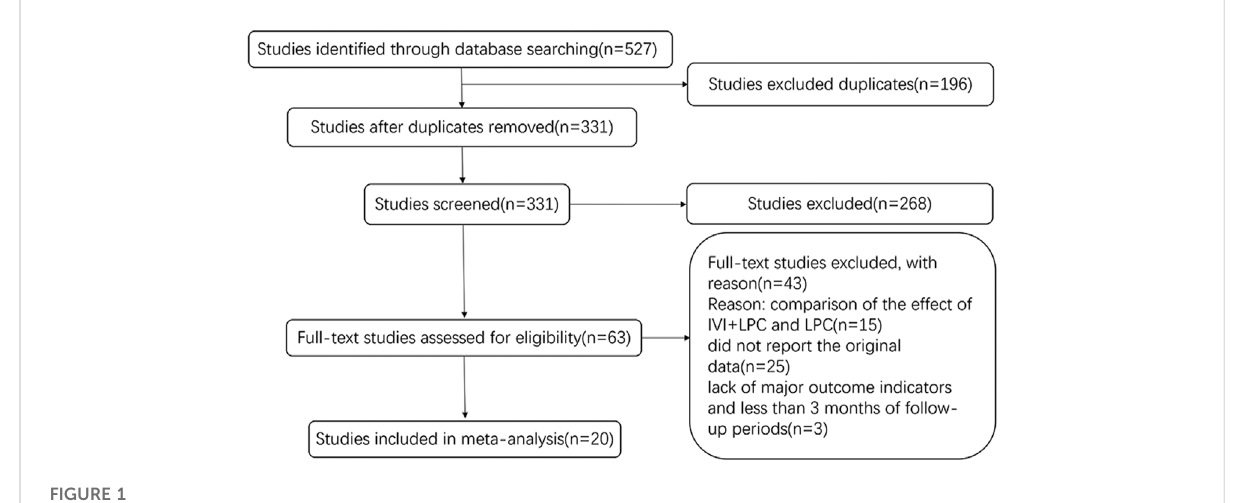
FIGURE 1 Flowchart of the study selection